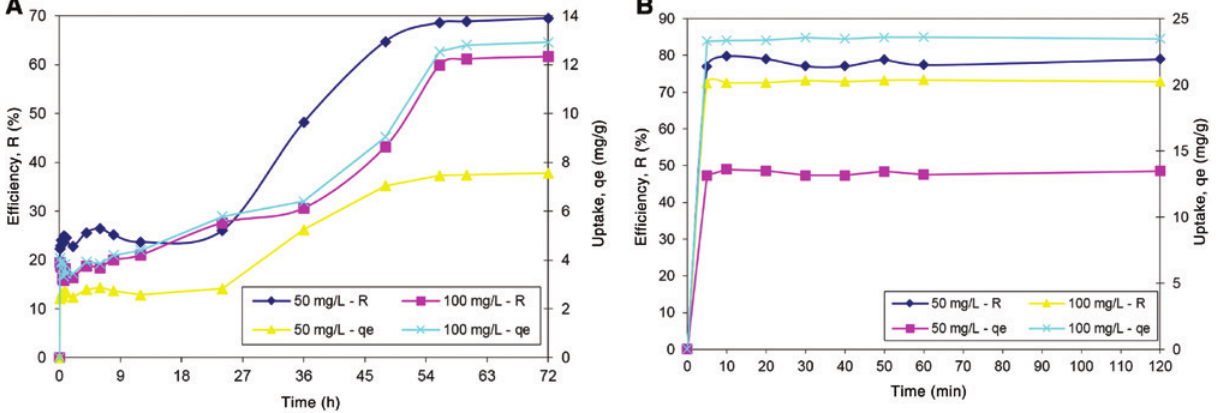
Figure 3: Influence of contact time on biosorption of Cd(II) ions by: (A) Rhodotorula sp. (pH 6, temperature 25 ° C, biomass dosage 5 g/l) and (B) B. megaterium (pH 4, temperature 25 ° C, biomass dosage 3